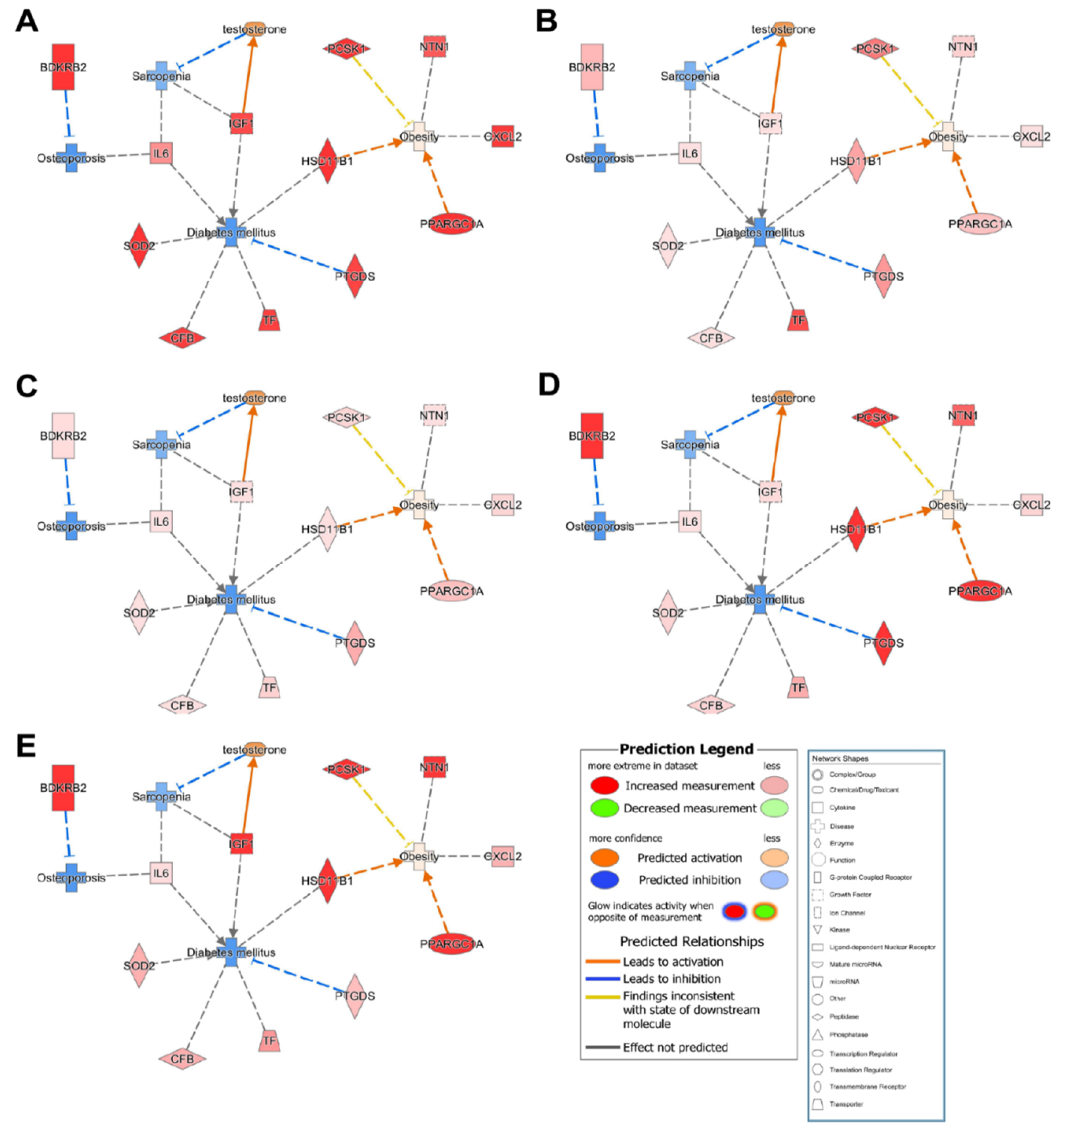
Figure 4. Functional relationship networks shared among osteoporosis-, sarcopenia-, obesity-, and diabetes-related genes. Control group participants no. ( A ) 1, ( B ) 2, ( C ) 3, ( D ) 4, and ( E ) 5.